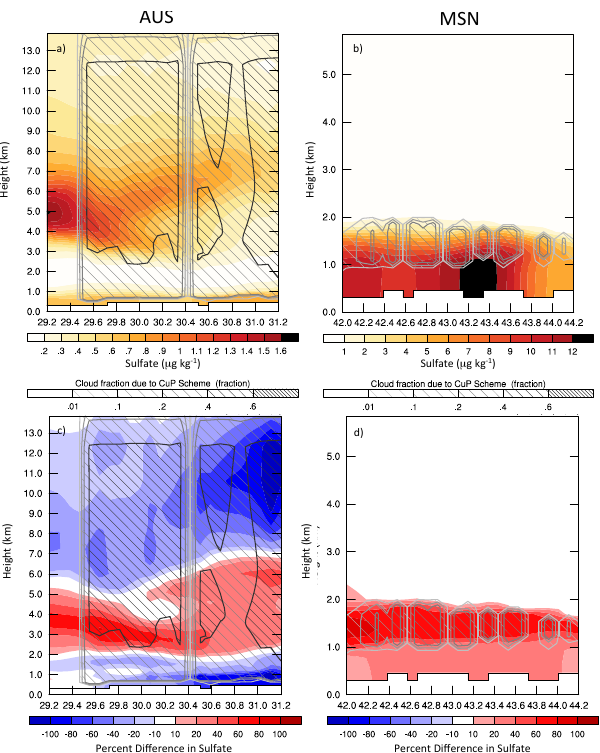
Figure 5. Same as Fig. 4 but for sulfate. ShallowOnly simulations both below and within the cloud layer. This is due to sulfate production within clouds, the detrainment of cloudy air with enhanced sulfate, and subse- quent downward transport of air back into the subcloud layer.